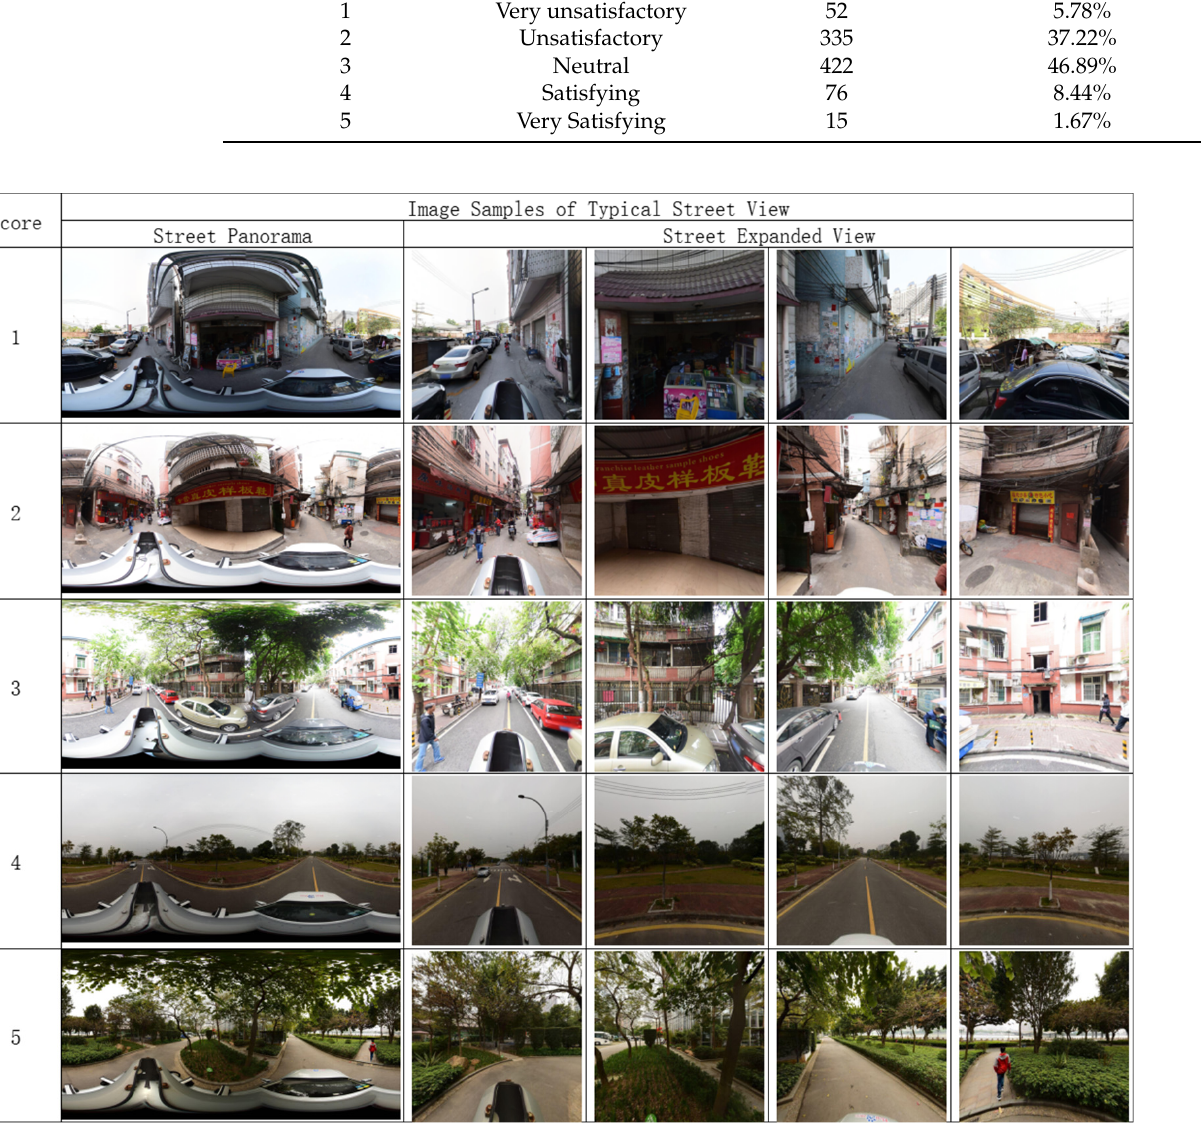
Figure 6. Typical Examples of Streetscape Images with a Score of 1 to 5.